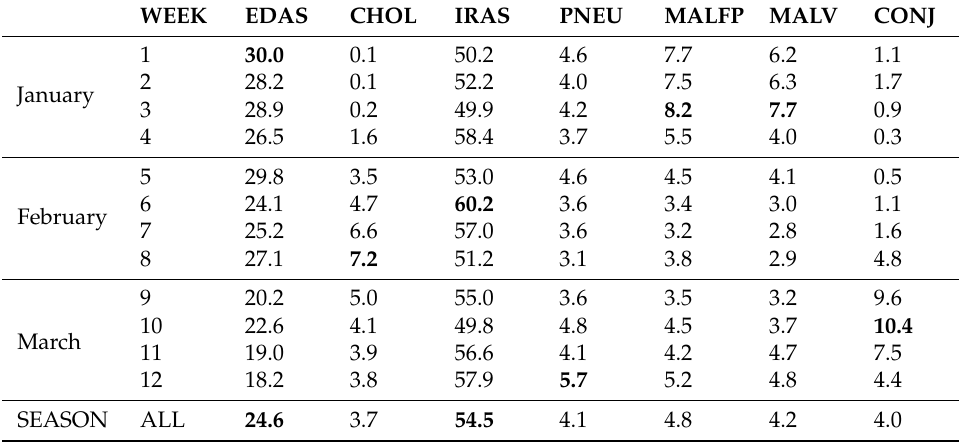
Table 1. Relative contribution (percentage) of each disease to total disease burden (12 weeks, January to March